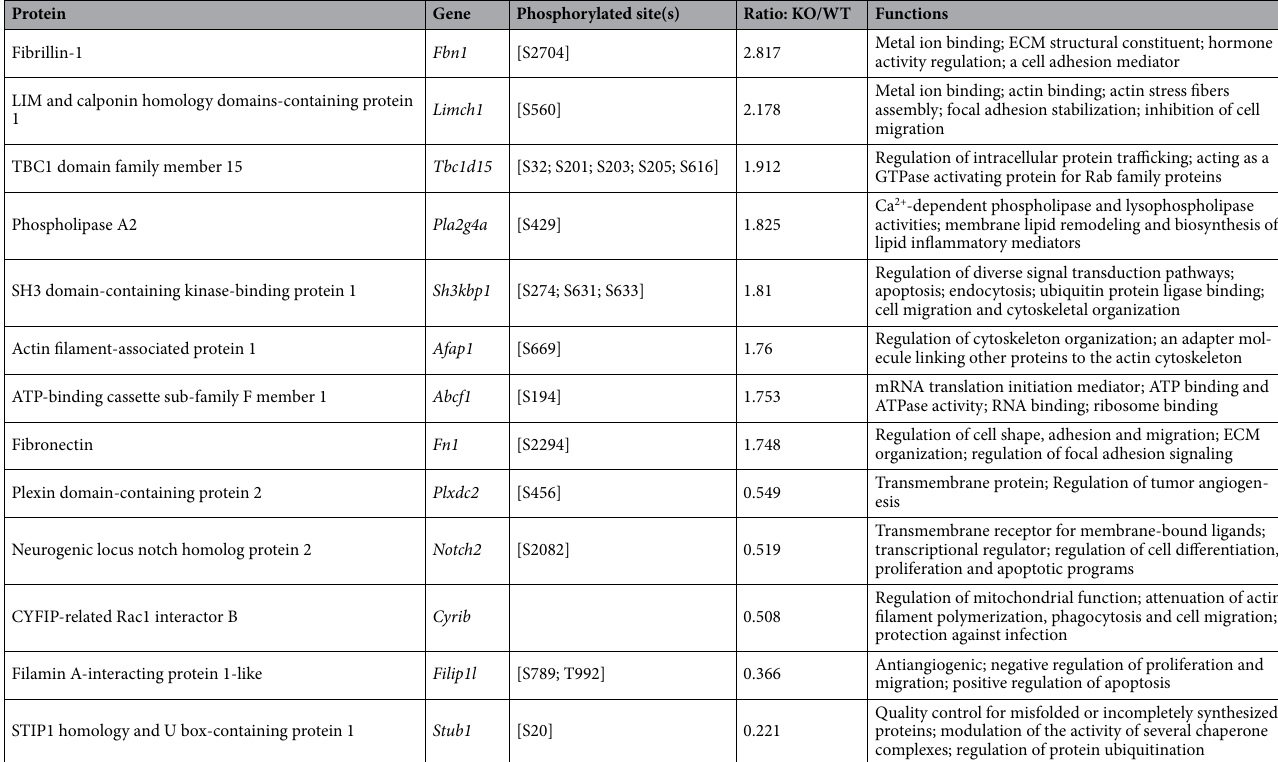
Table 1. List of differentially-regulated phosphorylated protein in Ahr +/+ (WT) and Ahr −/− (KO) MLFs identified using MS.